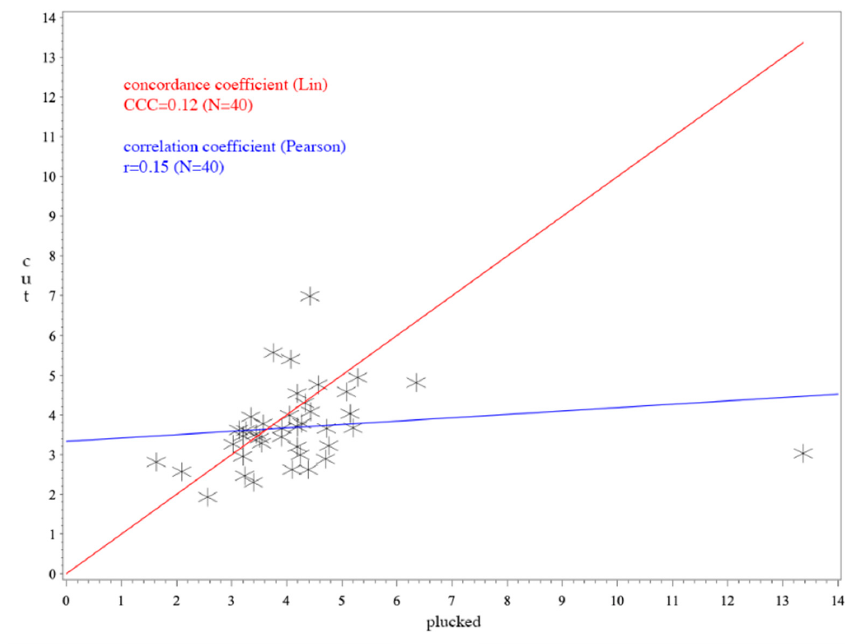
Figure 2. CCC and Pearson’s correlation coefficient of Anser ; p -value for Pearson’s correlation coefficient: p = 0.4297; the outlier of 13.37 pg/mm is included. The x-axis shows the corticosterone values of plucked feathers. The y-axis represents the values of cut feathers. The red line illustrates the concordance coefficient. The correlation coefficient is expressed in the blue line.